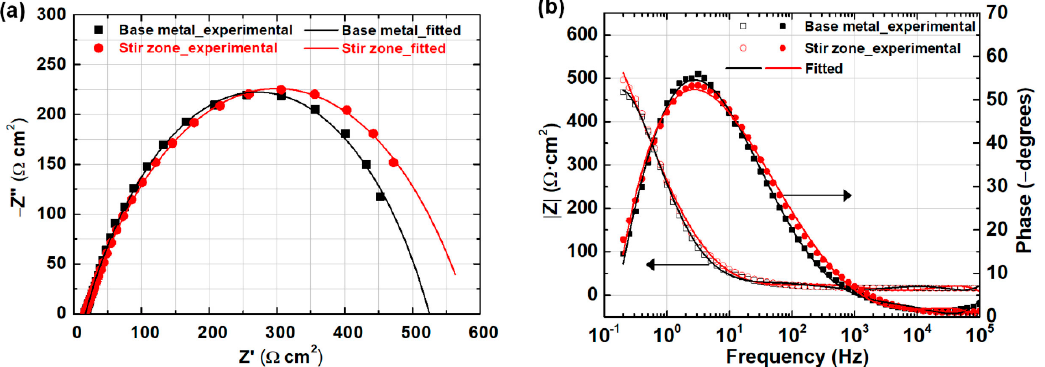
Figure 5. Results of the non-destructive test for estimating the surface resistance of the base metal and stir zone specimens using an electrochemical impedance spectroscope: ( a ) Nyquist plot and ( b ) Bode plot.